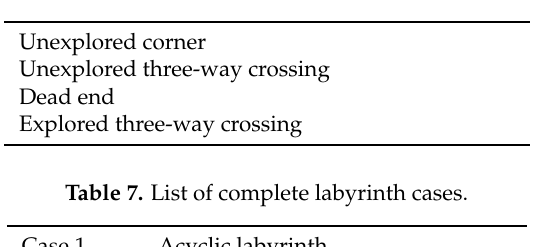
Table 6. List of canonical situations.